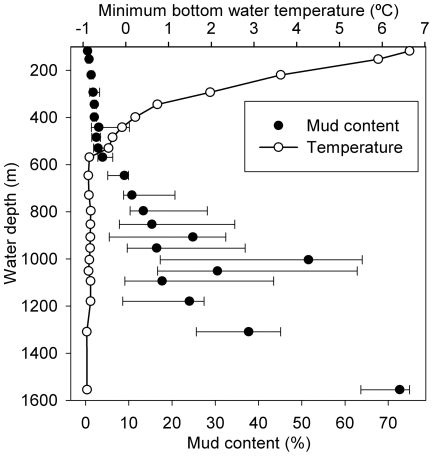
Variation in sediment mud content (<63 µm) and minimum bottom water temperature with depth.Median and interquartile range are shown for mud content.